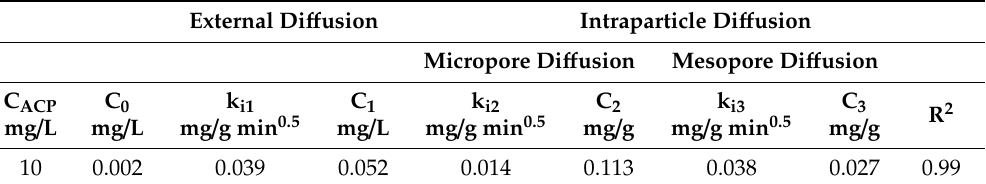
Table 3. Kinetic parameters of Weber–Morris